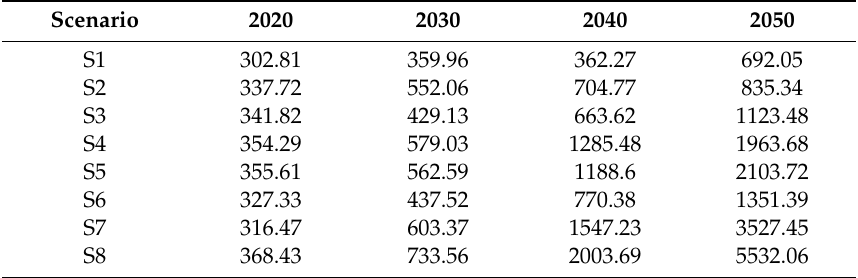
Table 11. Prediction of China (cid:48) s energy consumption carbon emissions in di ff erent